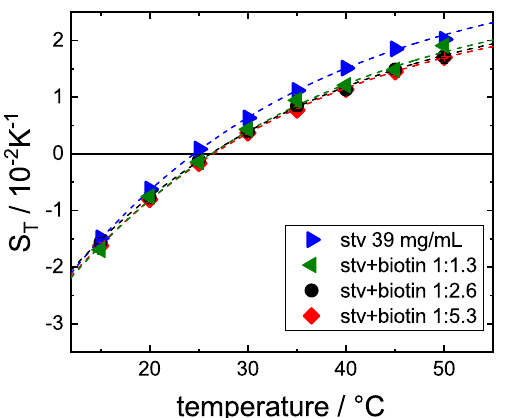
Figure 5. Soret coefficient S T against temperature for STV (39 mg/mL) with different stoichiometries of biotin. The results for STV without biotin (blue) and for the ratio 1:5.3 (red) are reproduced from Figure 4 in pale blue and red for easy comparison. The exact concentrations are summarized in Table A2 of the Appendix